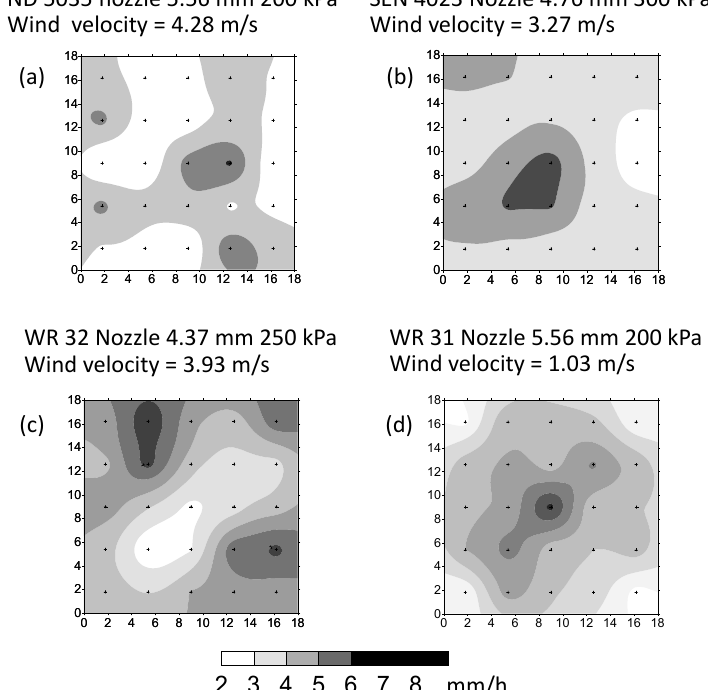
Figure 5. Water spatial distribution in the 18 m × 18 m solid-set configuration for specific sprinkler test.